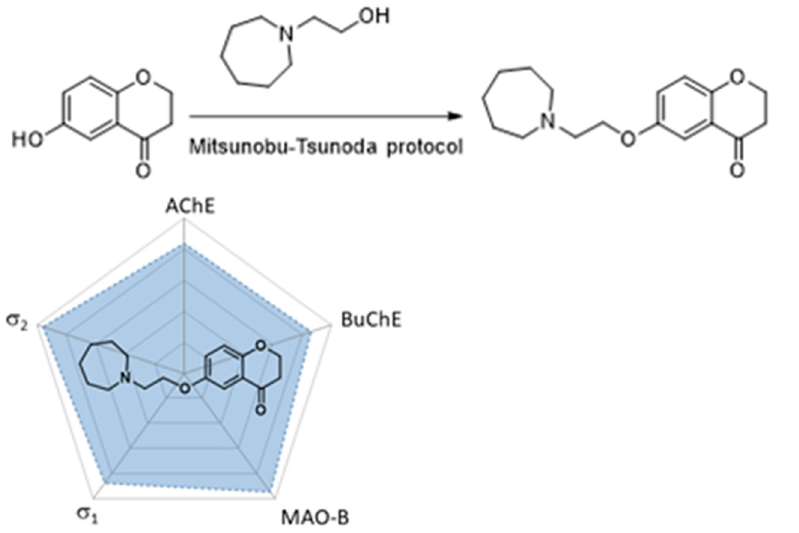
Figure 31. Chromanones as a Privileged Scaffold for Multineurotarget Anti-Alzheimer Agents .